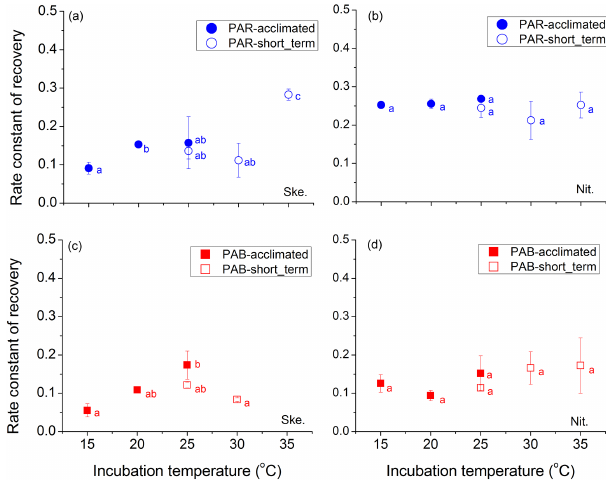
Figure 7. The rate constants for recovery of PAR-exposed Skele- tonema sp. (a) and Nitzschia sp. (b) , and rate constants for recovery of PAB-exposed Skeletonema sp. (c) and Nitzschia sp. (d) Under dim light, samples were incubated under grown temperature (ac- climated) or short-term elevated temperature (short_term). Vertical lines represent SD, n = 3. Data points with different lowercase let- ters (blue for PAR treatment, and red for PAB treatment) indicate significant differences among temperature